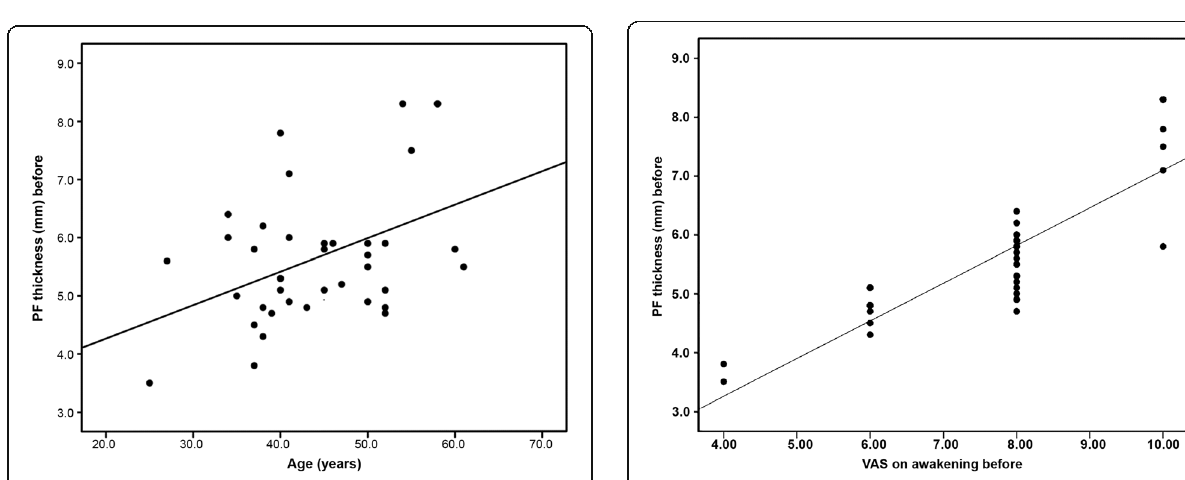
Fig. 1 Correlation between plantar fascia thickness before ESWT